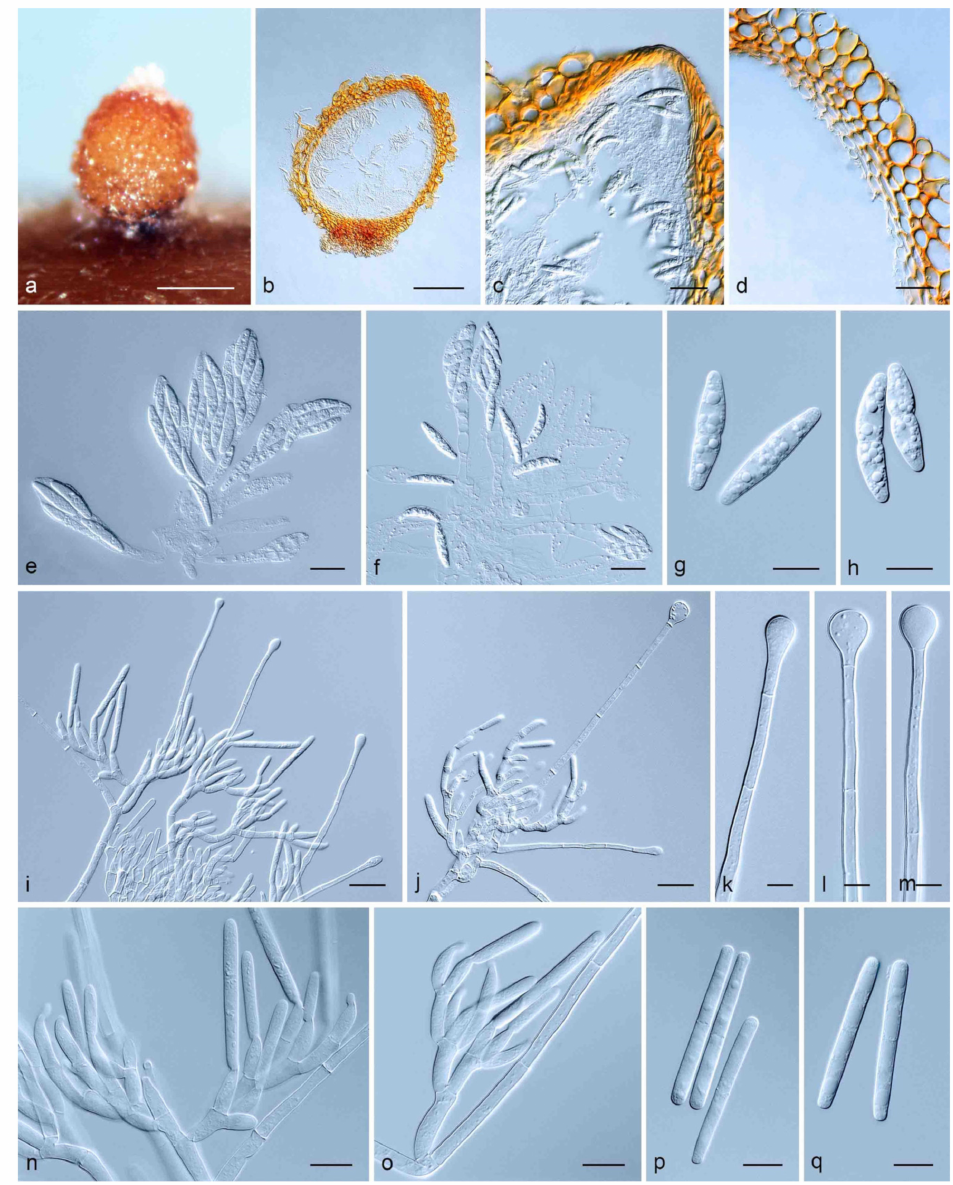
Figure A8. Calonectria hongkongensis . ( a ). Perithecium; ( b ). vertical section through a perithe- cium; ( c ). cells around ostiolar region of perithecium; ( d ). section through lateral perithecial wall; ( e , f ). asci; ( g , h ). ascospores; ( i , j ). macroconidiophore; ( k – m ). sphaeropedunculate vesicles; ( n , o ). conidiogenous apparatus with conidiophore branches and elongate doliiform to reniform phialides; ( p , q ). macroconidia.—Scale bars: a = 200 µ m; b = 100 µ m; c–f and i,j = 20 µ m; g,h and n–q = 10 µ m; k–m = 5 µ